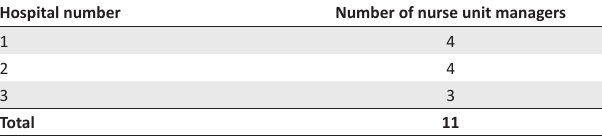
TABLE 1: Number of nurse unit managers interviewed per